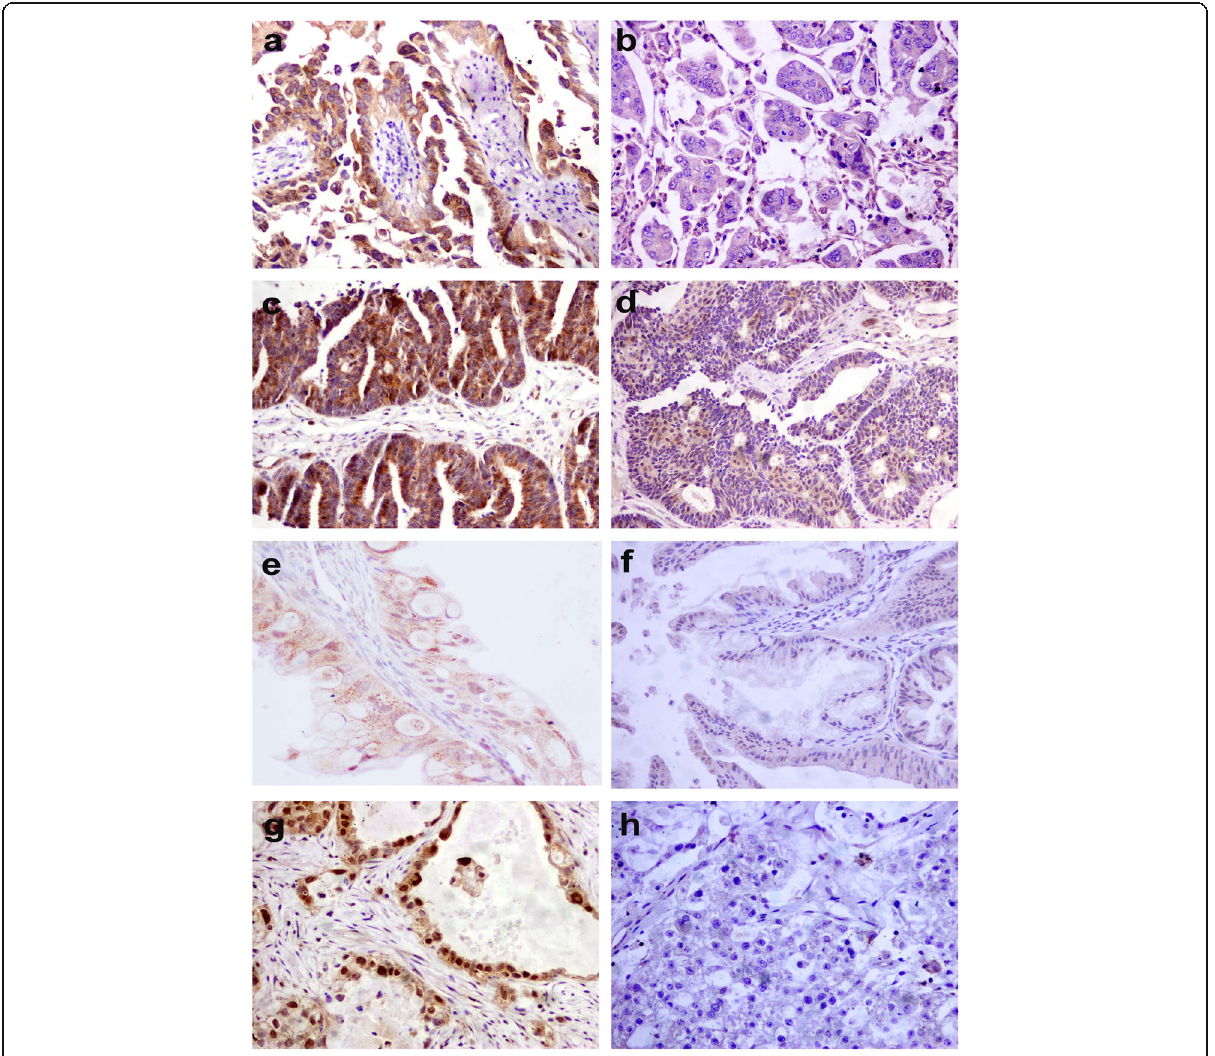
Fig. 1 Immunoreactivity patterns of REDD1 in ovarian carcinomas. a REDD1-high expression in serous carcinoma. b Serous carcinoma cells show no REDD1 staining. c Diffuse and strong positive staining for REDD1 in endometrioid carcinoma. d Endometrioid carcinoma cells show very weak cytoplasmic REDD1 staining. e REDD1-positive staining in mucinous adenocarcinoma. f Mucinous adenocarcinoma do not exhibit REDD1 staining. g Positive nuclear staining for REDD1 in clear cell carcinoma. h Clear cell carcinoma cells do not show staining for REDD1 (original magnification